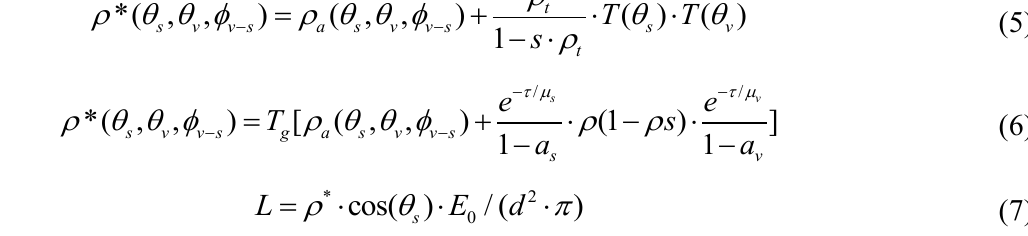
Table 5. The atmospheric parameters used for reflectance- and irradiance-based methods.